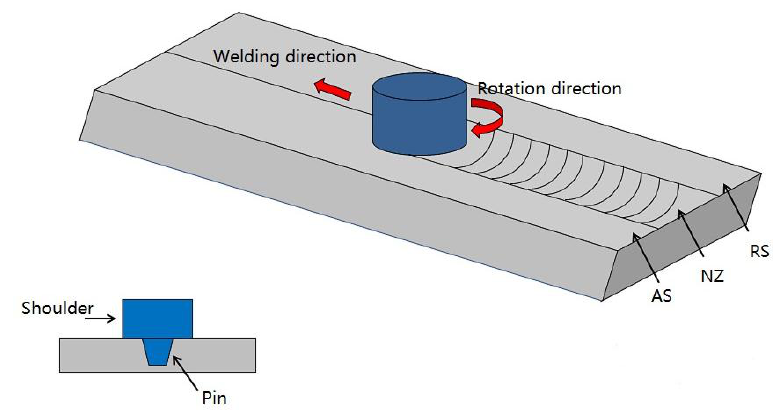
Figure 1. Schematic illustration of friction stir welding (FSW) (AS: Advancing Side; NZ: Nugget Zone; RS: Retreating Side).